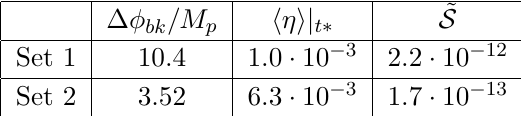
Table 4 . The e(cid:11)ects of backreaction for the two parameter sets given in section 4.2. The averaged second slow roll parameter is evaluated at the observationally relevant window, 60 efolds before the end of in(cid:13)ation, and will alter the value of n s given in table 2 debates. Both point-like and smeared anti-D3 brane sources have been shown to give rise to ill-behaved singularities [15{17, 53]. Recently, [54] showed (building upon [55, 56])